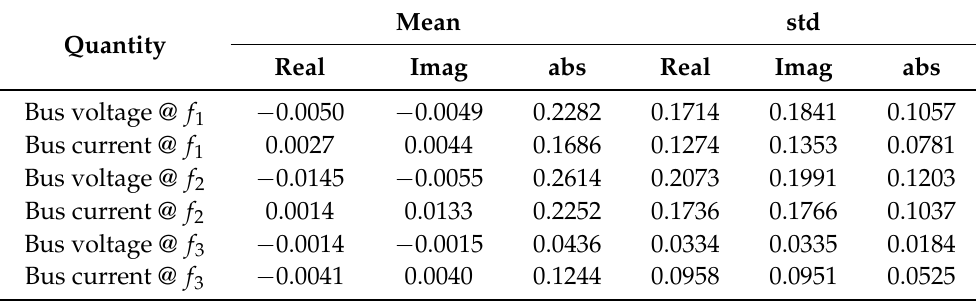
Table 3. Measures of dispersion of the MCM simulations for the three-converter network with 5m of line cable separation between